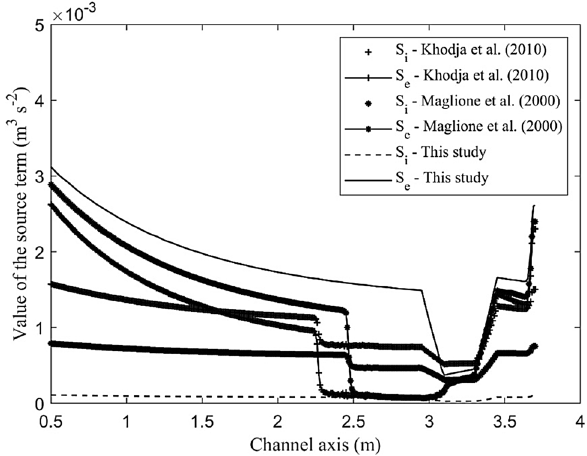
Fig. 9 A comparison of internal friction and external friction for dif- ferent drilling fluid, the rheology of drilling fluid based on the Her- schel–Bulkley fluid. The results are at a steady-state flow in the open Venturi channel, the inlet flow rate is 0.0056 m 3 s −1 , and the channel angle is −